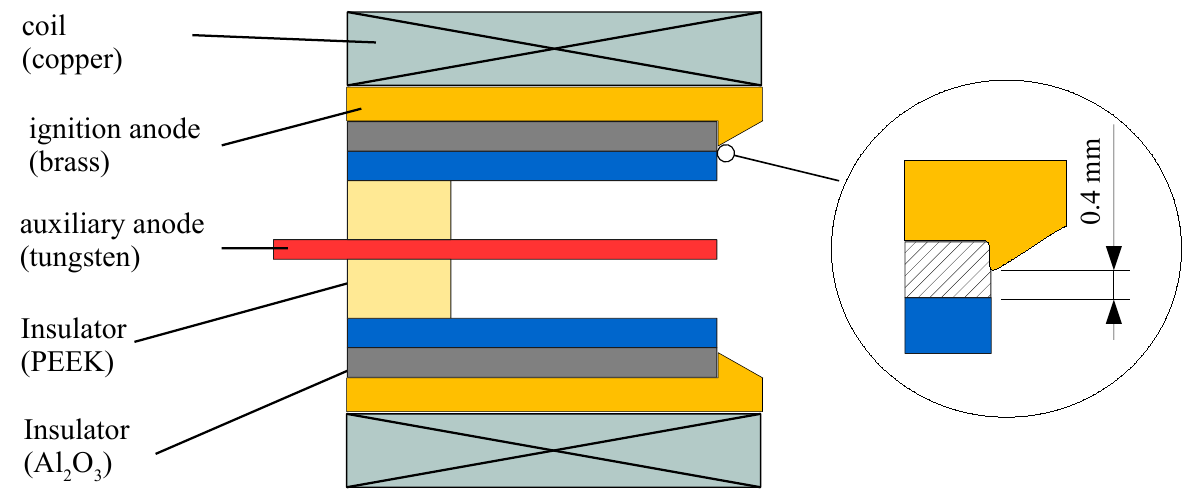
Figure 1. Schematic of the high efficient and reliable vacuum arc thruster (HEVAT) setup. The anode’s geometry allows a good fitting of the insulator and a reproducible anode-to-cathode gap of 0.4mm.